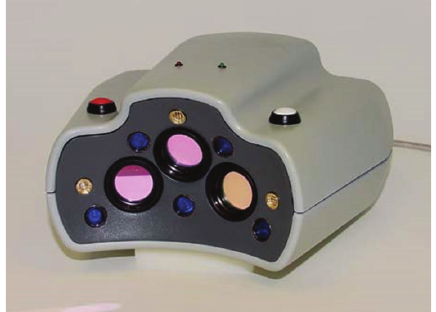
Figure 2: A medium power SEM shows 25 𝜇 m diameter beads covered by a thin polymer film.